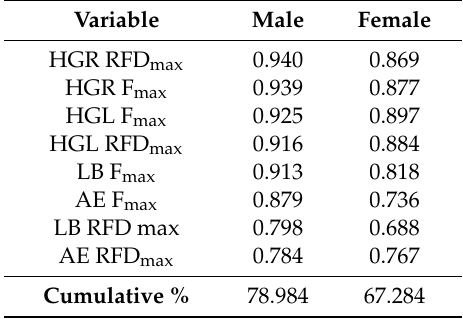
Table 4. Principal component analysis structure matrix.